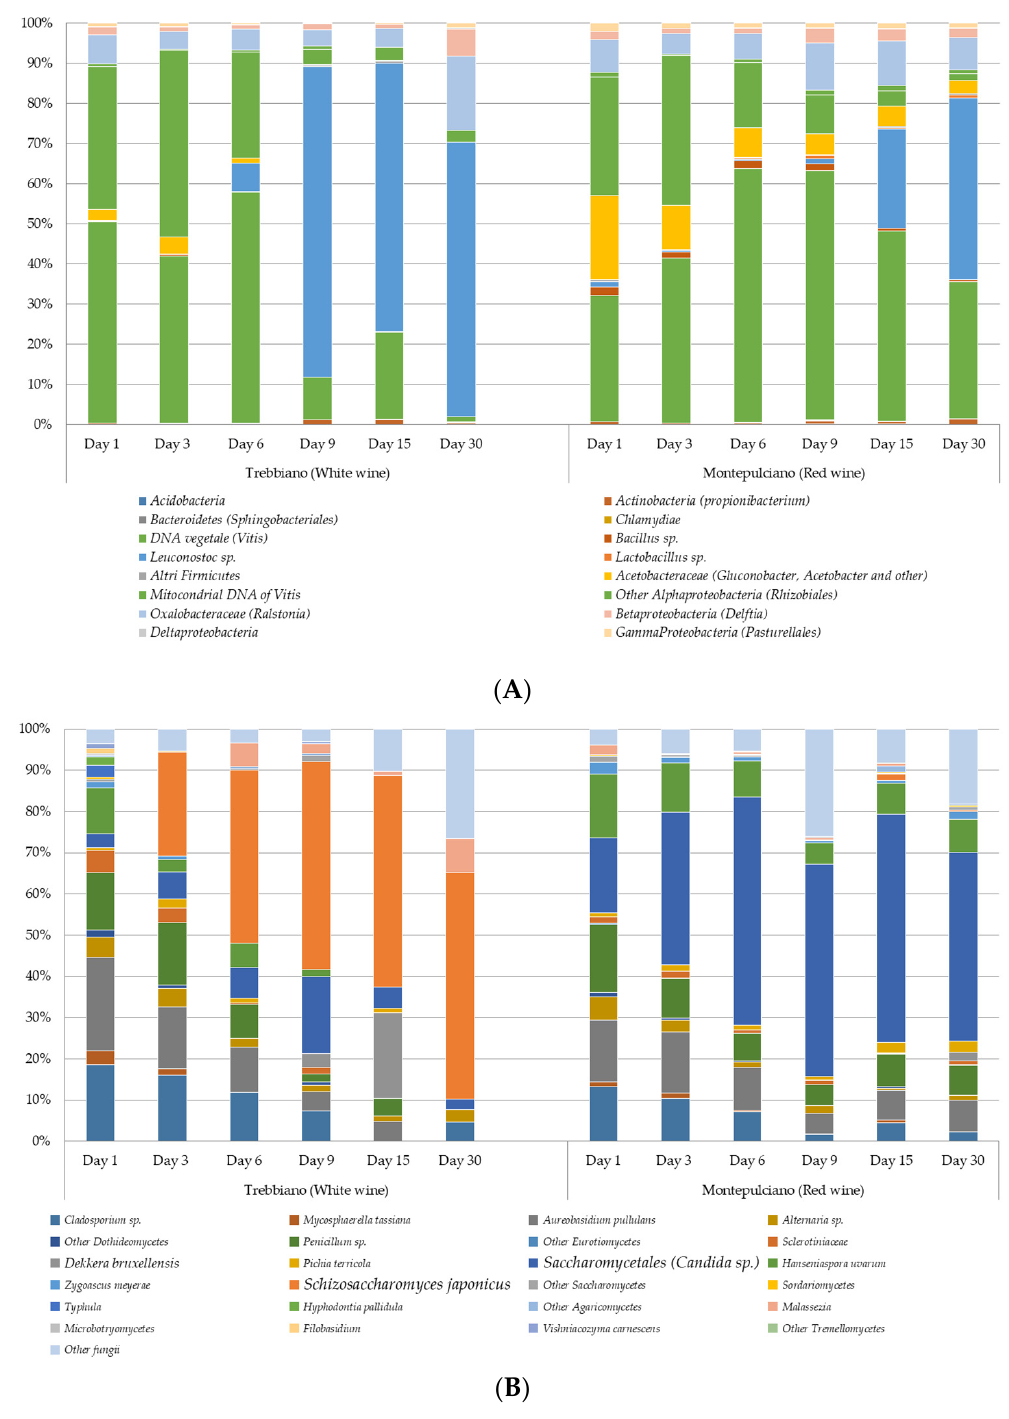
Figure 2. Main Taxa groups (species level or above) of bacterial ( A ) and fungi sequences ( B ) from different wines (Trebbiano and Montepulciano) using Illumina MiSeq. Each bar is a pool of two (Trebbiano) or four (Montepulciano) samples collected on six different days of the fermentation. For interpretation of the references to color in this figure legend, the reader is referred to the web version of this article.